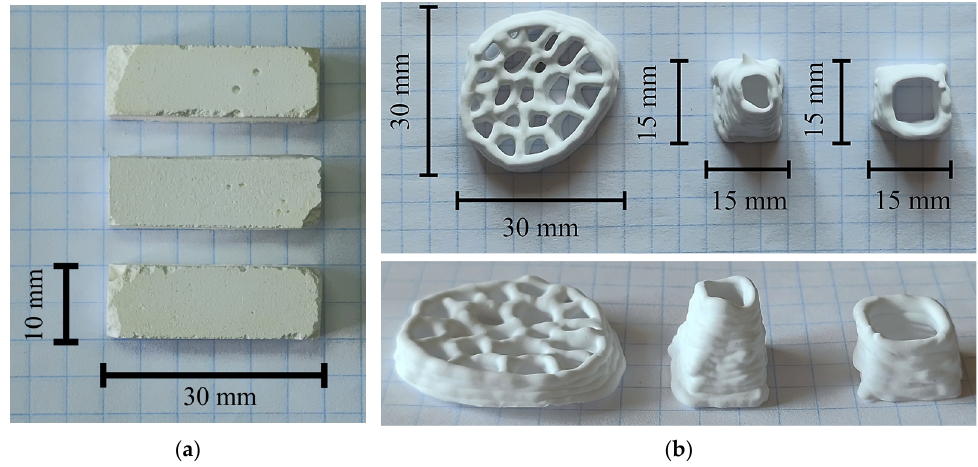
Figure 2. Samples formed by plastic molding from appropriate molds of size 30 mm × 10 mm × 10 mm ( a ). Samples formed by layer-by-layer extrusion hand molding ( b ).